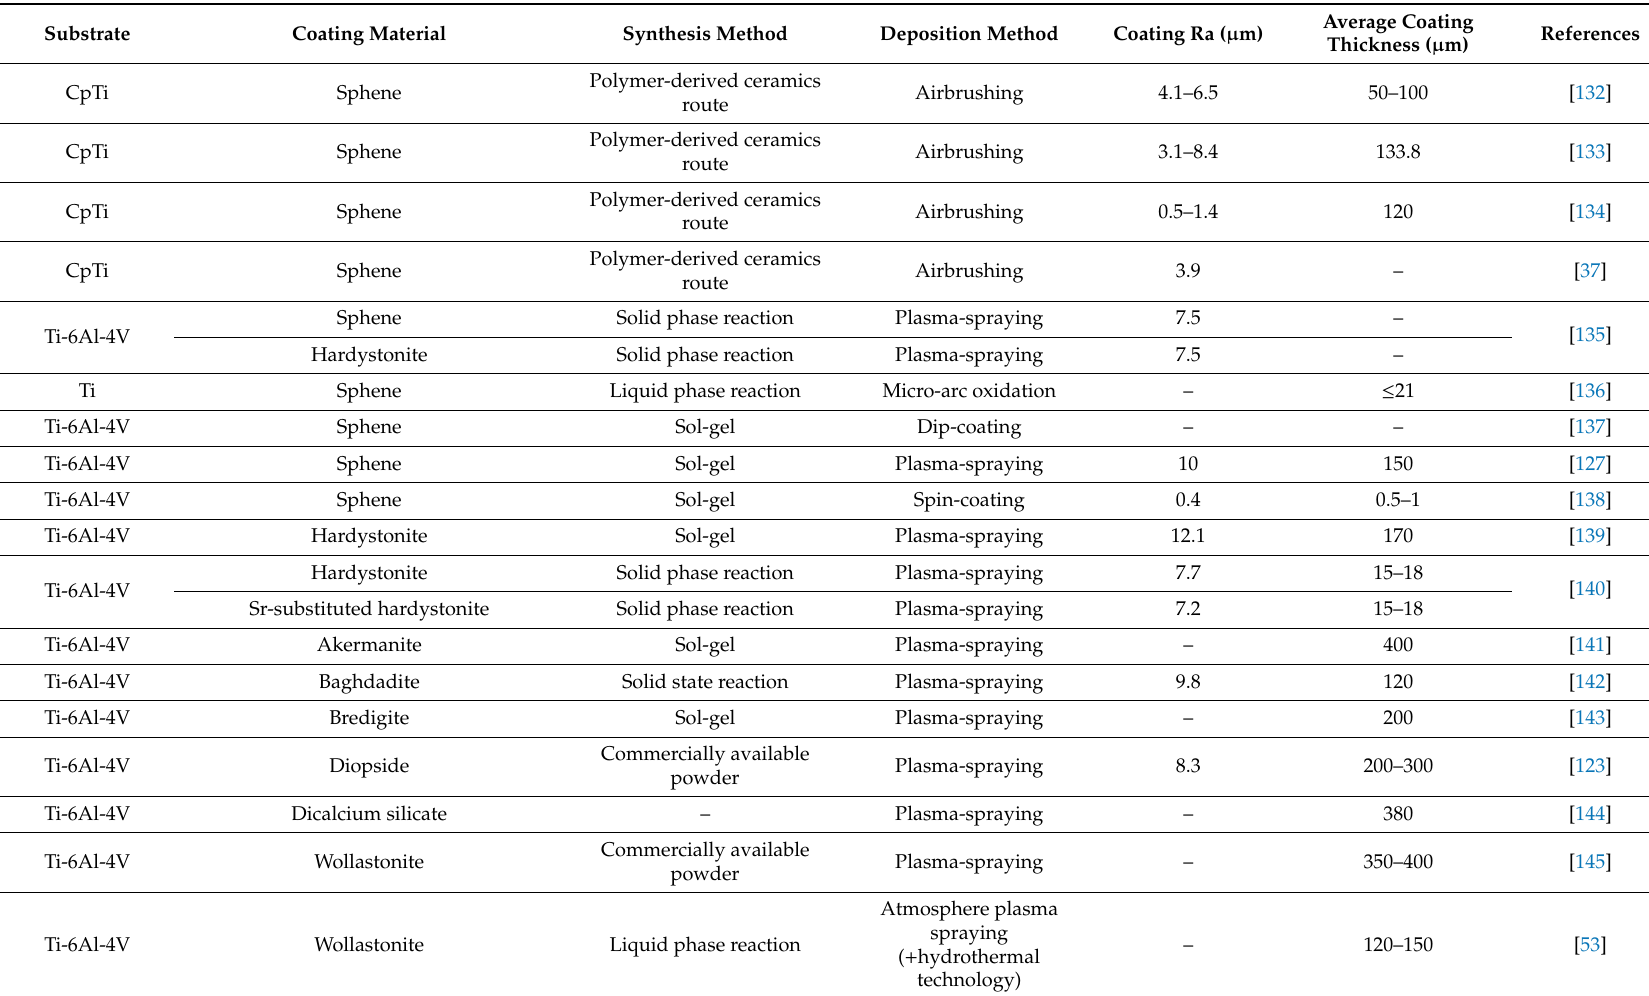
Table 4. Synthesis and deposition methods of bioactive coatings onto metallic substrates and their average roughness and